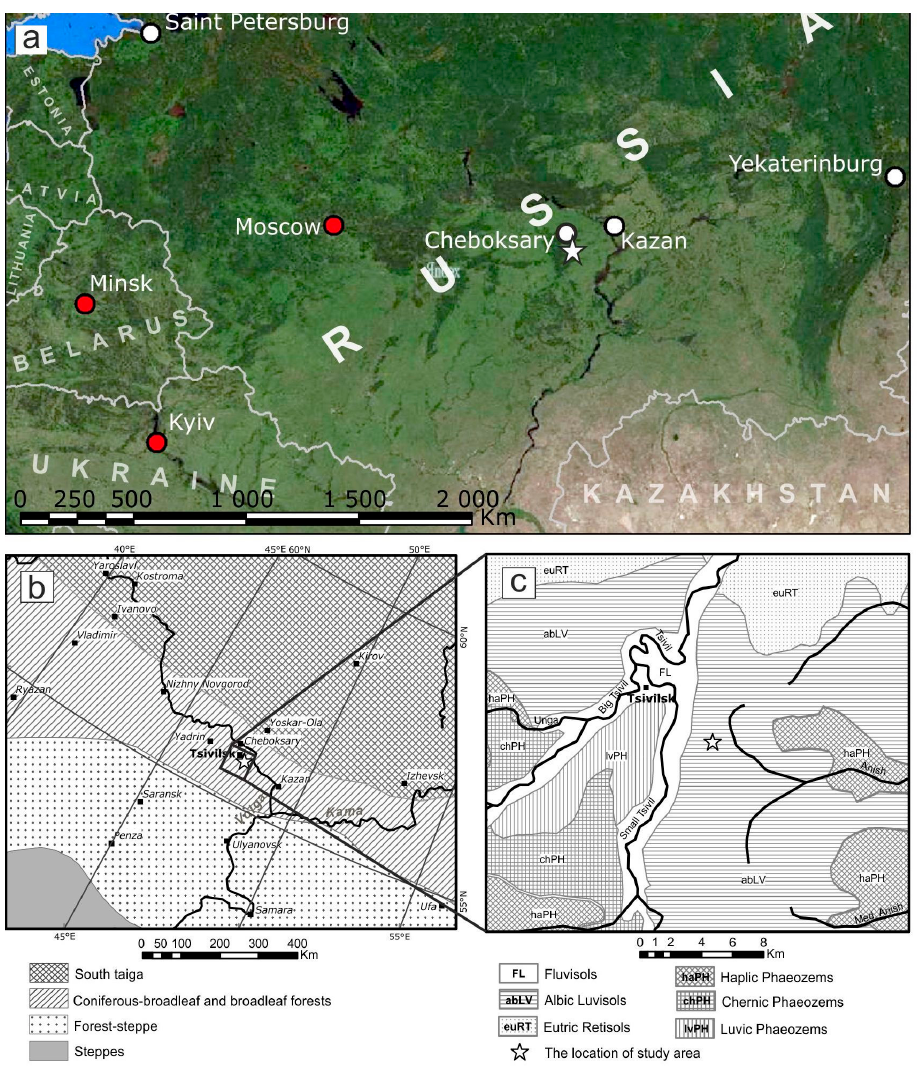
Figure 1. Location maps of the study area. ( a ) Regional-scale map; ( b ) Vegetation zones of the central part of the Russian Plain (modified after [21]); ( c ) Soil contours in the vicinity of Tsivilsk according to the State Soil Map of the Soviet Union 1:1,000,000 [22]. Reference Soil Groups according to IUSS Working Group WRB [23].